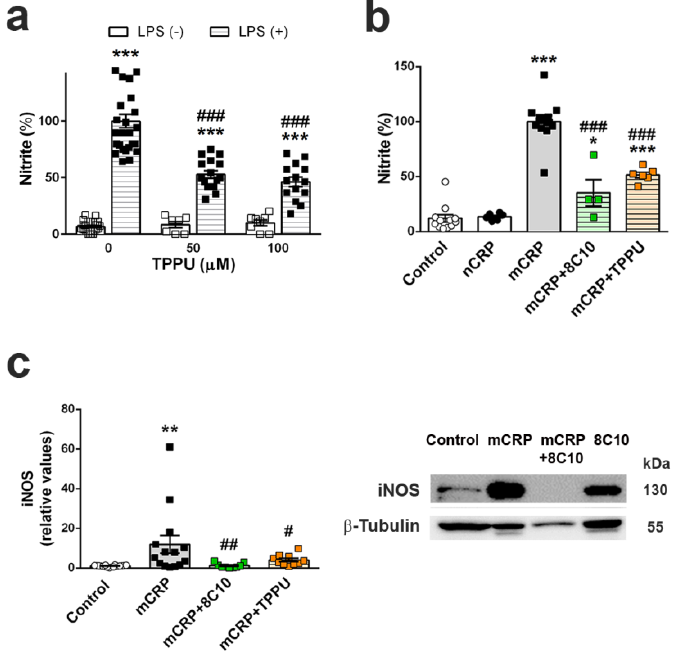
Figure 8. Nitric oxide generation by mCRP in BV2 microglial cells was inhibited by 8C10 and TPPU. ( a ) TPPU decreased the generation of nitric oxide induced by lipopolysaccharide (LPS), as shown by nitrite detection in the culture media of BV2 cells after 24 h of incubation. ( b ) Increased nitric oxide generation by 24 h exposure to mCRP was decreased by both the antibody 8C10 and the anti-inflammatory agent TPPU, while pentameric native CRP (nCRP) had no effect. ( c ) Levels of iNOS protein increased in BV2 cells treated with mCRP, and the increase was inhibited by 8C10 and TPPU. Representative blots of each experimental group are shown in the same order as the densitometric analysis values in the histogram, the blot images reproduce a cropped gel, and full- length gel is presented in Supplementary Figure S10. Values are mean ± SEM (( a ) TPPU 0 µM Con- trol N = 22, LPS N = 26; TPPU 50 µM Control N = 7, LPS N = 16; TPPU 100 µM Control N = 8, LPS N = 14. ( b ) Control N = 12, CRP N = 6, mCRP N = 12, mCRP + 8C10 N = 4 and mCRP + TPPU N = 6. ( c ) Control N = 18, mCRP N = 14, +TPPU N = 10). Statistics: *** p < 0.001 compared to the corre- sponding Control group, +++ p < 0.001 compared to the LPS (+) group without TPPU in ( a ); * p < 0.05, *** p < 0.001 compared to the Control group, ### p < 0.001 compared to mCRP group in ( b ); ** p < 0.01 compared to the Control group, # p < 0.05 and ## p < 0.001 compared to mCRP group in ( c ).